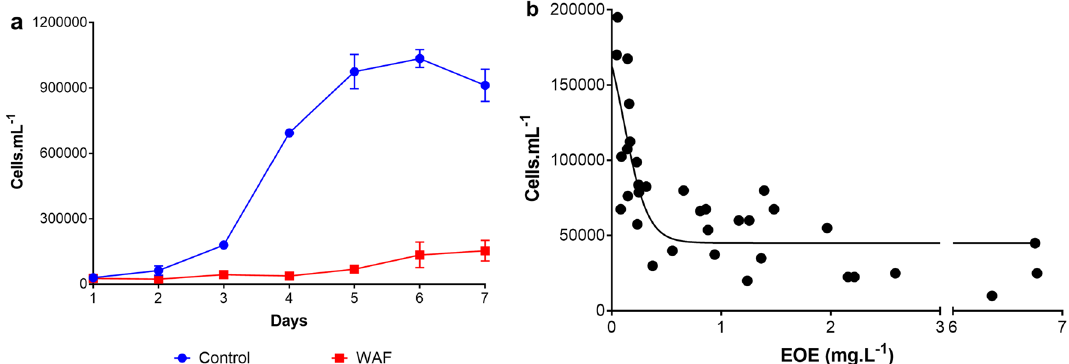
Figure 1. Growth response of T. pseudonana . ( a ) average daily cell counts of T. pseudonana ( ±) in Control and WAF (n = 3), ( b ) Cell counts of T. pseudonana under different estimated oil equivalents (oil